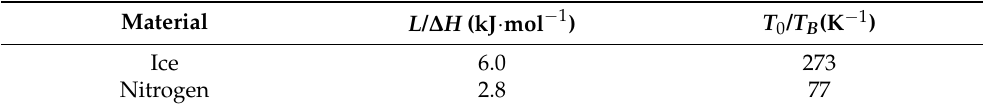
Table 1. A table showing the values of the constants of ice and liquid nitrogen employed in the determination of the α -factor.